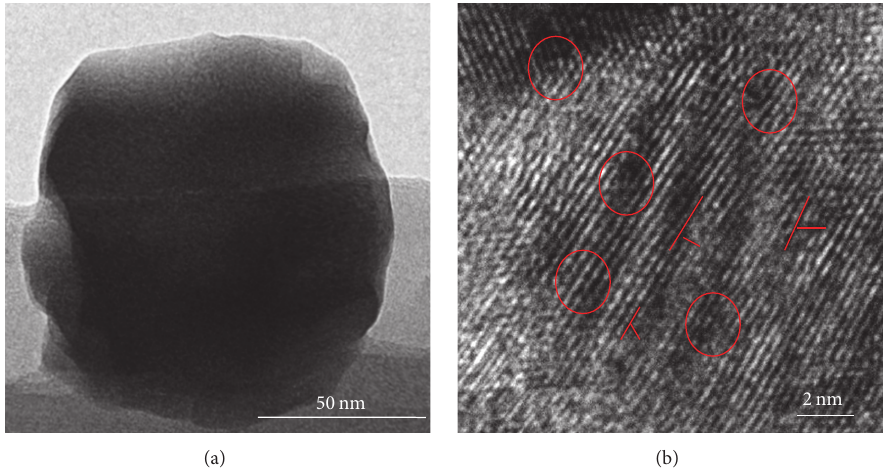
Figure 6: TEM and high-resolution images for 𝛽 -CoC 2 O 4 ⋅ 2H 2 O sample (a) (mechanical solid-state